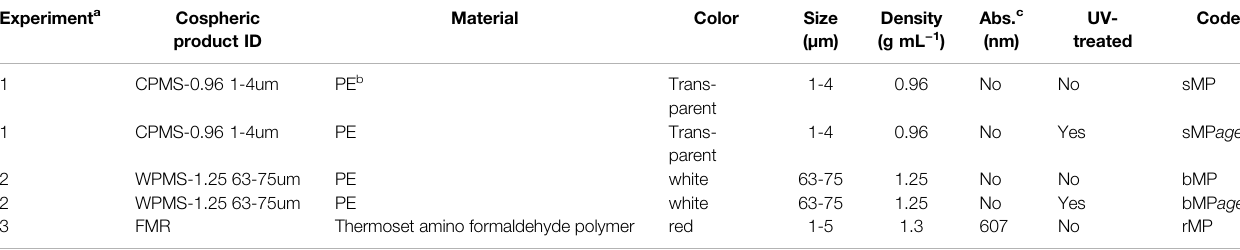
TABLE 1 | Physical and chemical properties of the microplastic particles (MP) used in this study. Experiment